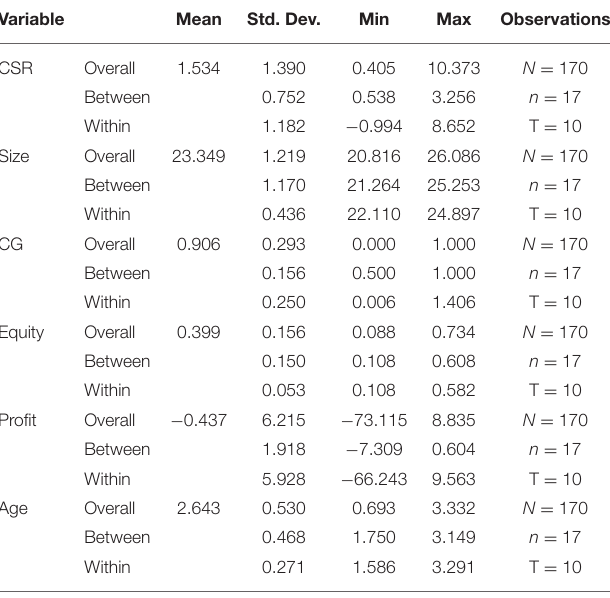
TABLE 8 | Results of descriptive statistics of the Tobit model variables. Variable